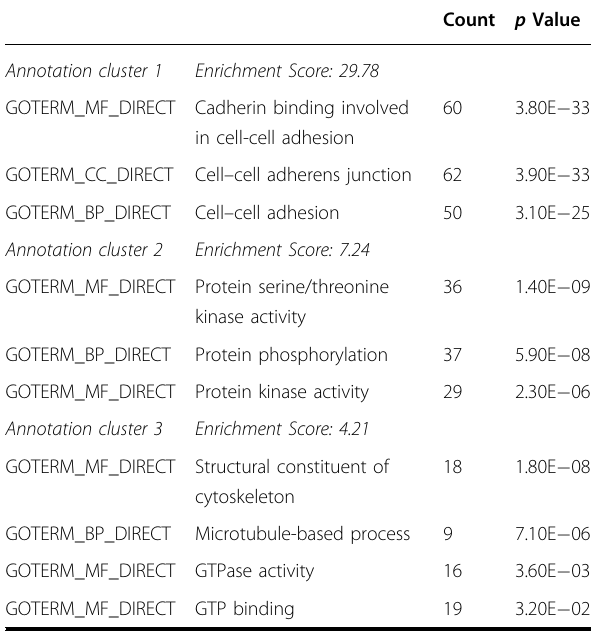
MF molecular function, CC cellular function, BP biological process. Table 2 Enriched pathways of the upregulated phosphoproteins (fold change >1.5) in HuH-7 R cells by DAVID based on KEGG pathways.